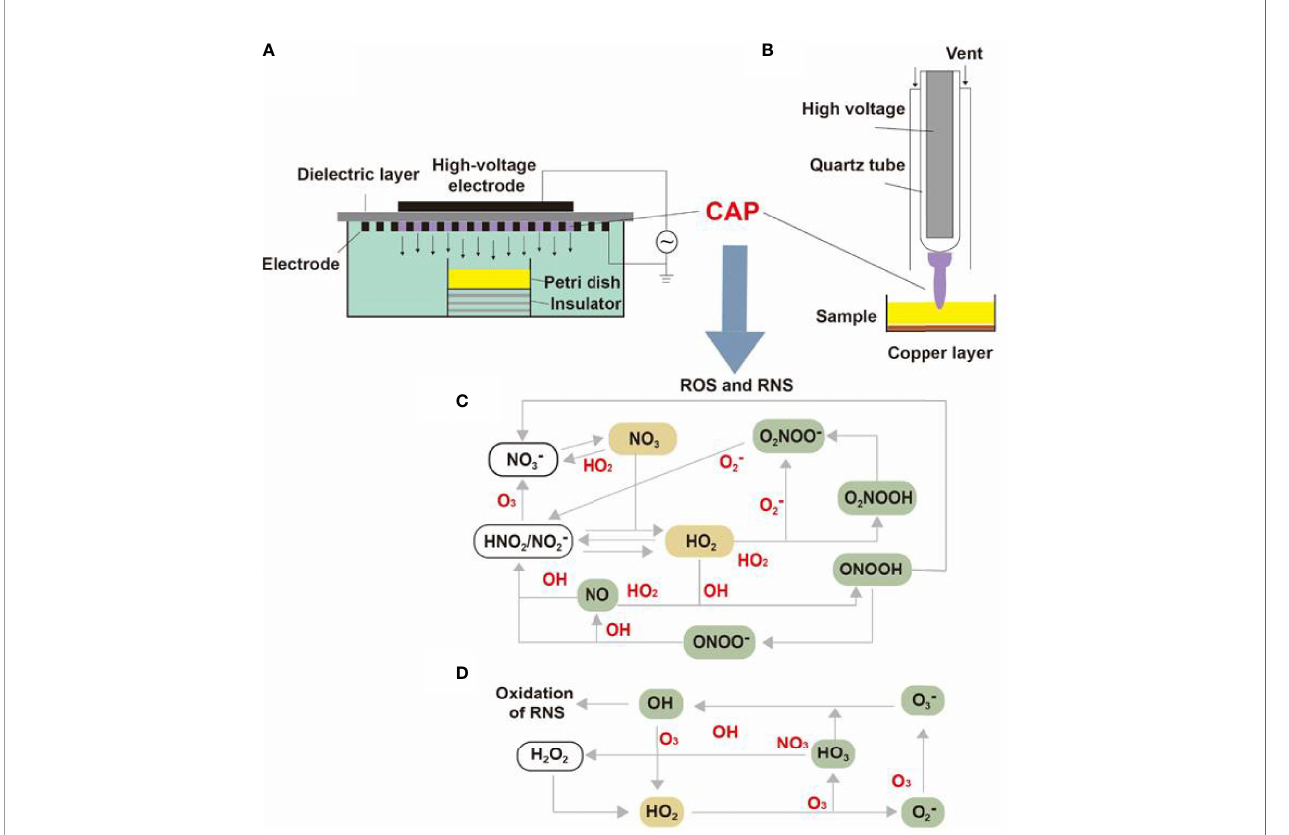
FIGURE 2 | The internal structure of surface DBD and APPJ and the transformation of CAP particles. The internal structures of (A) surface DBD and (B) APPJ were consisted of electrodes, high-voltage probes, quartz tubes, and a dielectric layer. The (C) RNS and (D) RNS generated under high voltage could be converted into different molecules or ions and fi nally synthesized into effective particles like 1 O 2 , ONOO - , NO 2- , NO 3- , and H 2 O 2